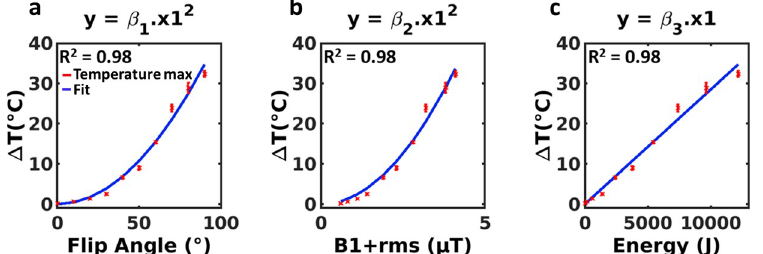
Fig 5. Dependence of temperature increase in a single pixel on flip angle, B 1+rms and deposited energy by the MRI sequence. Each point corresponds to the mean of the temperature over 5 dynamic acquisitions at the end of the energy deposition (acquisition #90) obtained for FA HM ranging from 0˚ to 90˚. The same pixel was selected for each experiment. Error bars correspond to the σ T over the same 5 dynamic acquisitions. A quadratic curve fit was performed for the two first curves and a linear fit for the last one. Coefficients resulting from the fits were β 1 = 4.3 ± 0.1.10 − 3 ˚C/˚ 2 , β 2 = 2.0 ± 0.05˚C/( μ T) 2 and β 3 = 2.3 ± 0.1 10 − 3 ˚C/J,